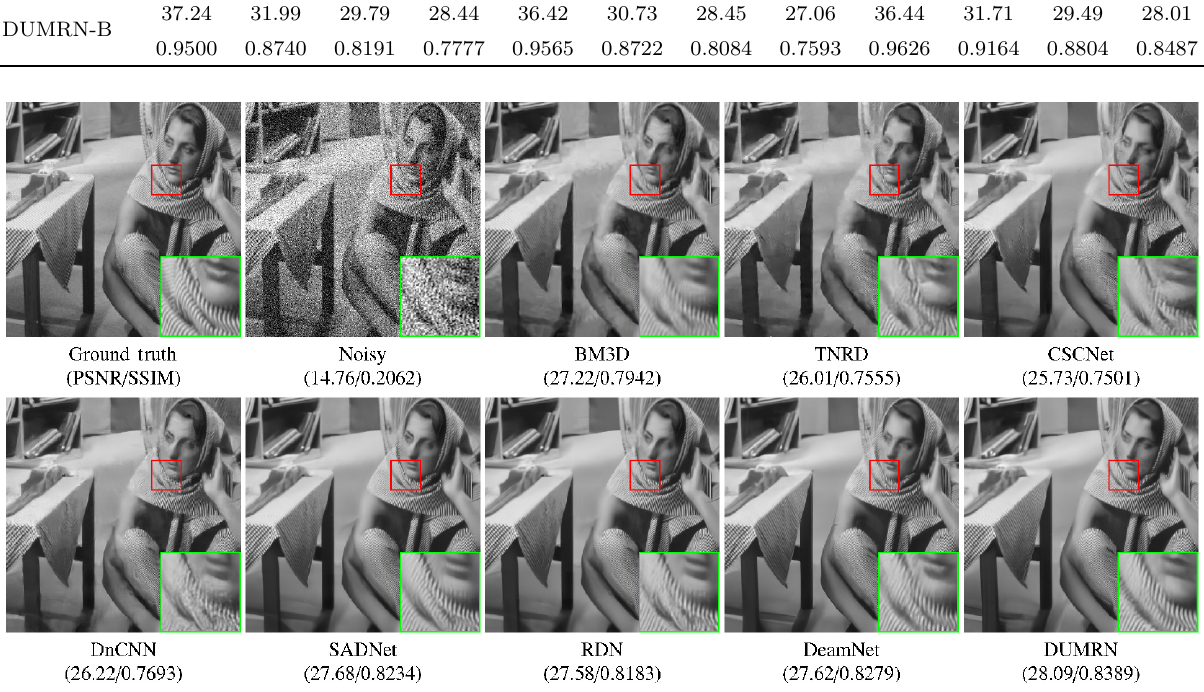
Fig. 3 Gray-scale image denoising results on image 09 in Set12 with noise level σ =